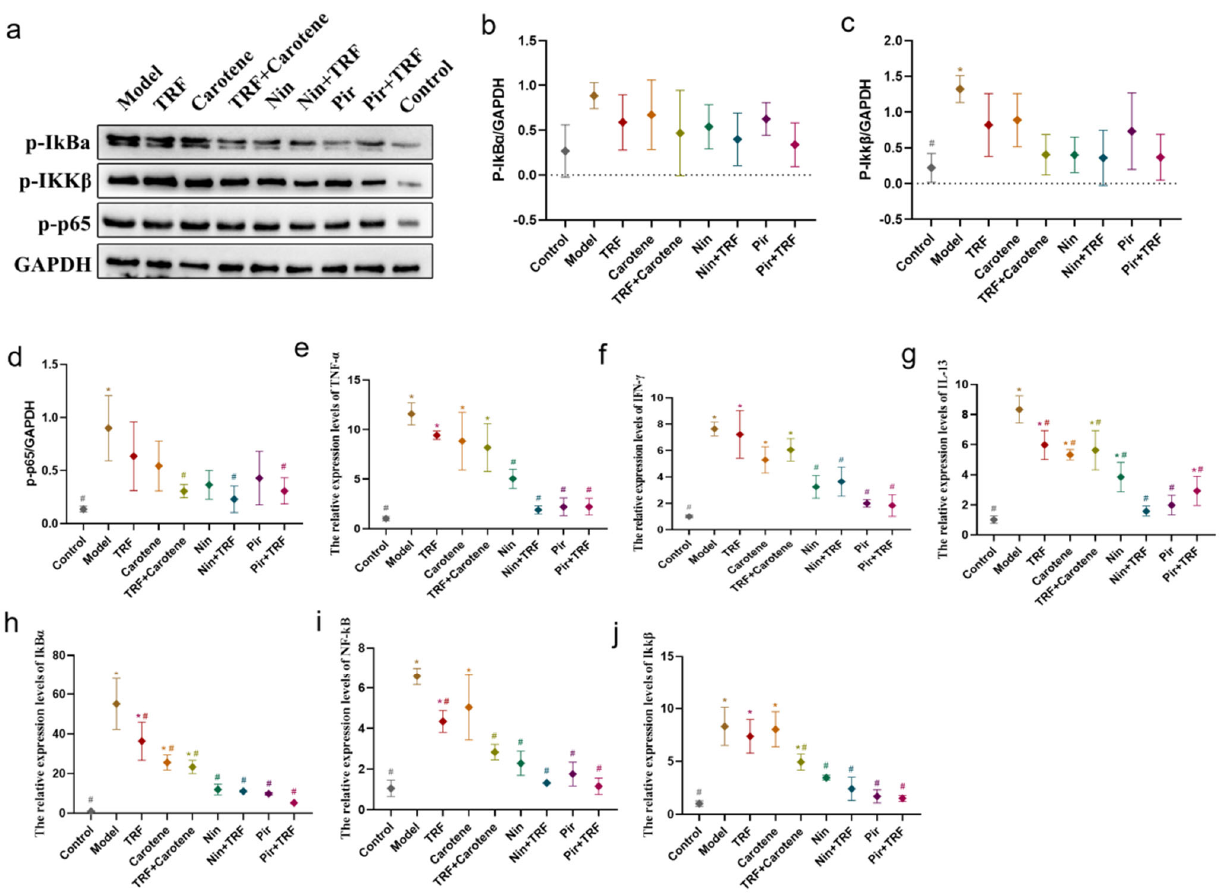
Figure 11. PF was protected by TRF via the inhibition of the NF ‐κ B signaling pathway: ( a – d ) The expression of fibrosis proteins induced by BLM in SD rats was decreased; protein expressions of p ‐ IkB α ( b ), Ikk β ( c ) and p ‐ p65 ( d ) in lung samples were examined by WB analysis; n = 3. ( e – j ) Representative statistical analyses of TNF ‐α ( e ), IFN ‐γ ( f ), IL ‐ 13 ( g ), IkB α ( h ), NF ‐κ B ( i ) and Ikk β ( j ) in mRNA by RT ‐ qPCR; n = 3. Note: * represents p < 0.05 in comparison to the control group; # represents p < 0.05 in comparison to the model group.